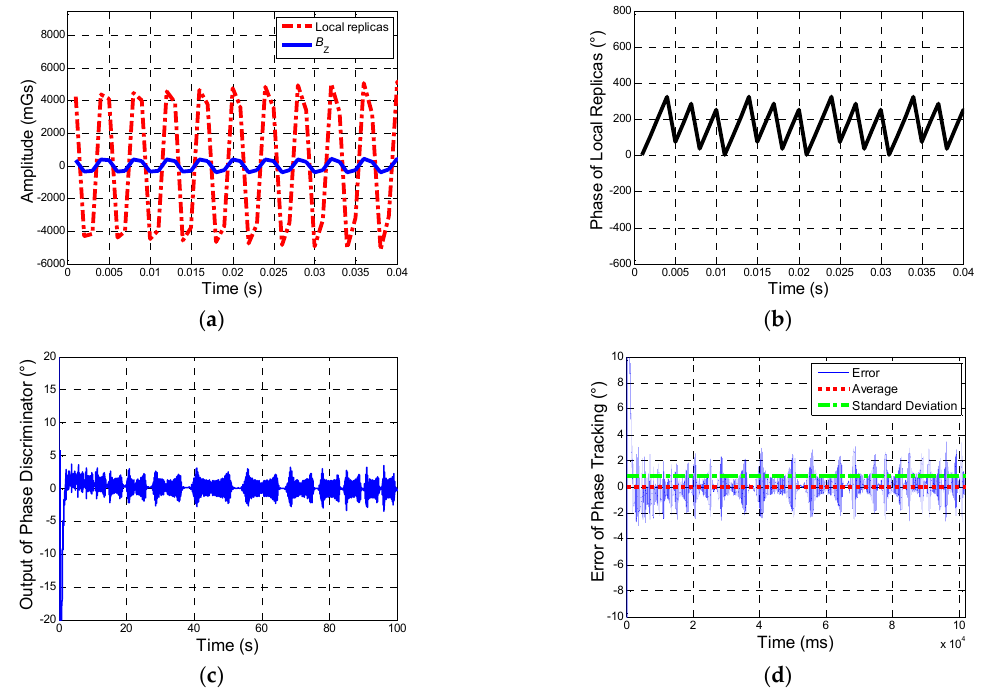
Figure 12. Tracking results. ( a ) Description of Z B and local replicas (amplitude of local replicas is amplified 8 times for the convenience of comparison). ( b ) Description of phase of local replicas. ( c ) Description of the output of phase discriminator. ( d ) Description of error of phase tracking.